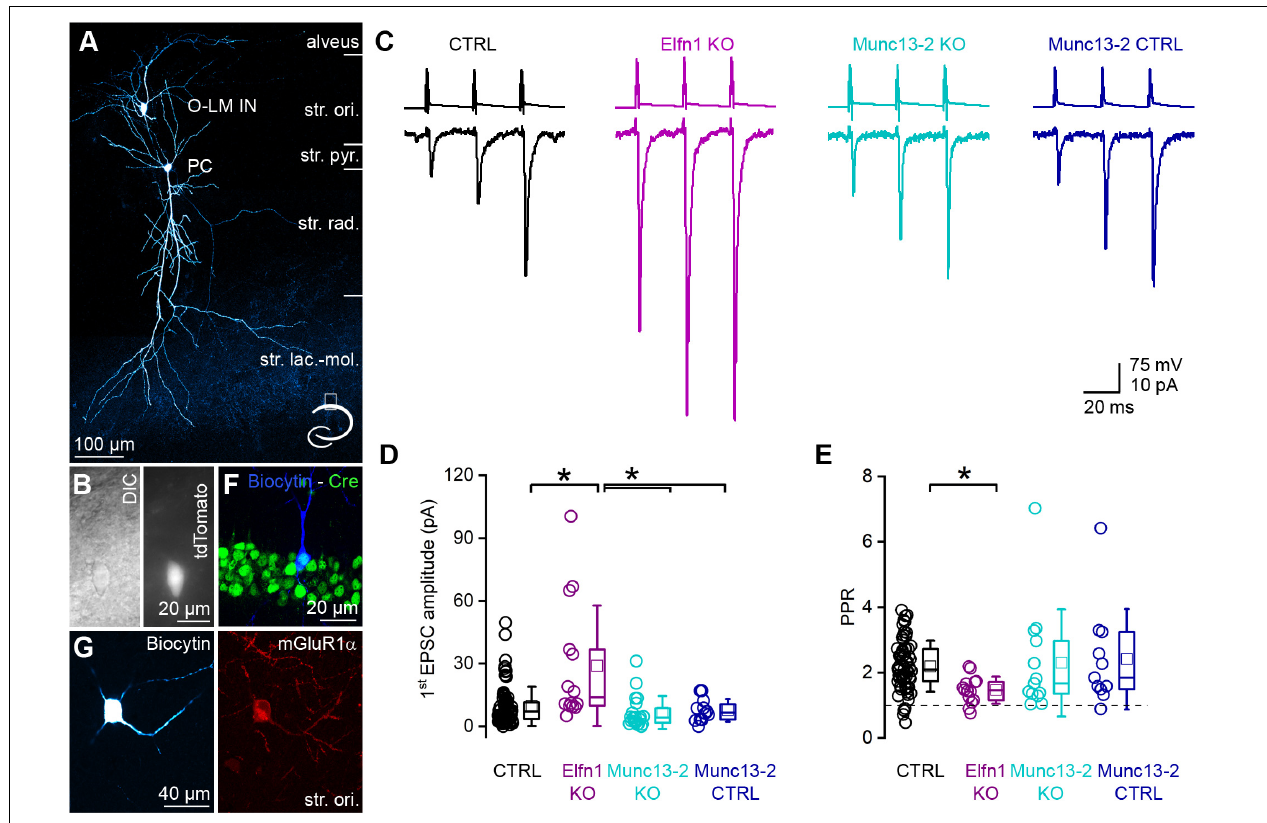
FIGURE 4 | Removal of Munc13-2 does not change the peak amplitude and short-term plasticity of unitary EPSCs between CA1 PCs and mGluR1 α expressing INs. (A) In vitro whole-cell patch-clamp recorded and biocytin filled CA1 PC and O-LM IN. The axonal arbor of the IN is visible in the stratum lacunosum-moleculare. Cartoon depicts the location of the cells within the hippocampus. (B) DIC image of the O-LM IN shown in panel (A) (left) and fluorescent tdTomato signal of the same cell (right). (C) Unitary EPSCs (lower traces) evoked by a train of 3 APs @ 40 Hz in a presynaptic CA1 PC (upper traces) recorded in postsynaptic O-LM INs in the dorsal CA1 region of the hippocampus. Black traces are from a control, magenta traces from an Elfn1 knock-out, cyan traces from a Munc13-2 conditional knock-out, dark blue traces from a Munc13-2 conditional knock-out littermate control. (D) The first EPSC is significantly larger (*) in the Elfn1 knock-out mouse than in any of the controls or in the Munc13-2 conditional knock-out mice ( p = 5.44 × 10 − 4 , Kruskal-Wallis ANOVA, post hoc Dunn’s test: p = 0.003, 0.00024, 0.041, ctrl vs. Elfn KO, Elfn KO vs. Munc13-2 KO, Elfn KO vs. Munc13-2 ctrl, respectively) while there is no change in the peak amplitude in the Munc13-2 conditional knock-out mouse compared to any of the controls (Kruskal–Wallis ANOVA, post hoc Dunn’s test p = 0.49 and 1, ctrl vs. Munc13-2 KO, control vs. Munc13-2 control). (E) The short-term facilitation is significantly less pronounced in the Elfn1 knock-out mouse ( p = 0.0065, Kruskal-Wallis ANOVA, post hoc Dunn’s test: p = 0.0034, ctrl vs. Elfn knock-out) while there is no change in the short-term plasticity in the Munc13-2 conditional knock-out mouse compared to any of the controls (Kruskal-Wallis ANOVA, post hoc Dunn’s test, p = 1, ctrl vs. Munc13-2 KO, Munc13-2 KO vs. Munc13-2 control). (F) In vitro recorded and biocytin filled PC (blue) expressing Cre-recombinase (green) that is localized to the PC nucleus. Single confocal image. (G) A biocytin filled IN with truncated axon (left) expresses mGluR1 α (right red). Maximum intensity projection of four confocal images separated by 1 µ m. Box plots represent median and 25/75 percentiles, square represent the mean value, whiskers represent SD. str. ori., stratum oriens, str. pyr., stratum pyramidale, str. rad., stratum radiatum, str. lac.-mol., stratum